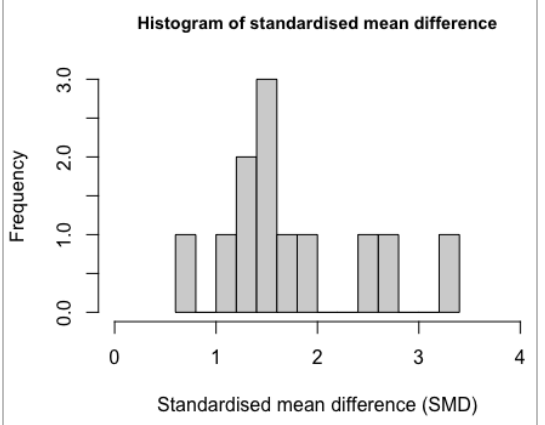
Figure A3. The distribution of the SMD of HC versus MCI_AD is slightly skewed but still approxi- mately normal.